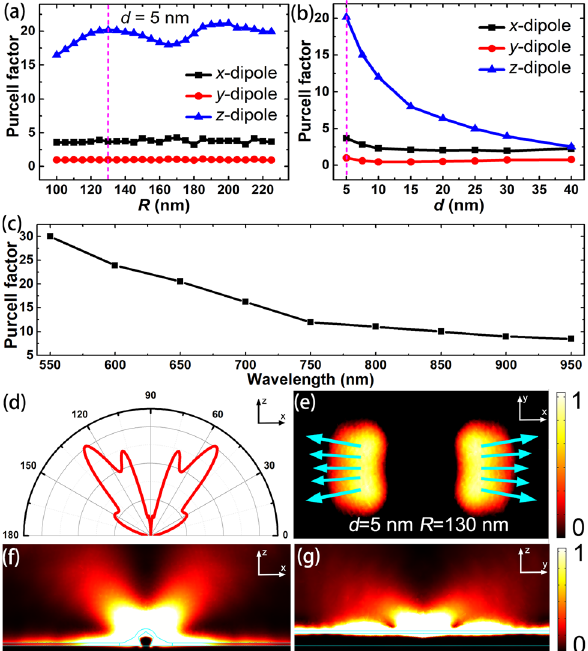
Figure 4: (a) Variation in the Purcell factor with the radius of the silver nanowire for the dipole oriented along the x- , y- , and z- axes when d = 5 nm. (b) Variation in the Purcell factor for the dipole orientedalongthe x- , y- ,and z- axeswith d (thedistancebetweenthe dipole and the silver nanowire) when R = 130 nm. (c) Response spectrum of the Purcell factors for the proposed metallic nanostructure with d = 5 nm. (d) Far- fi eld ( | E far | 2 ) distribution in different directions of the x-z plane with x = 0 μ m and (e) intensity ( | E | 2 ) distribution in the x - y plane with z = 2 μ m when d = 5 nm and R =130nm.Distributionsoftheintensity( | E | 2 )in(e)the x - z planewith y = 0 μ m and (f) the y - z plane with x = 0 μ